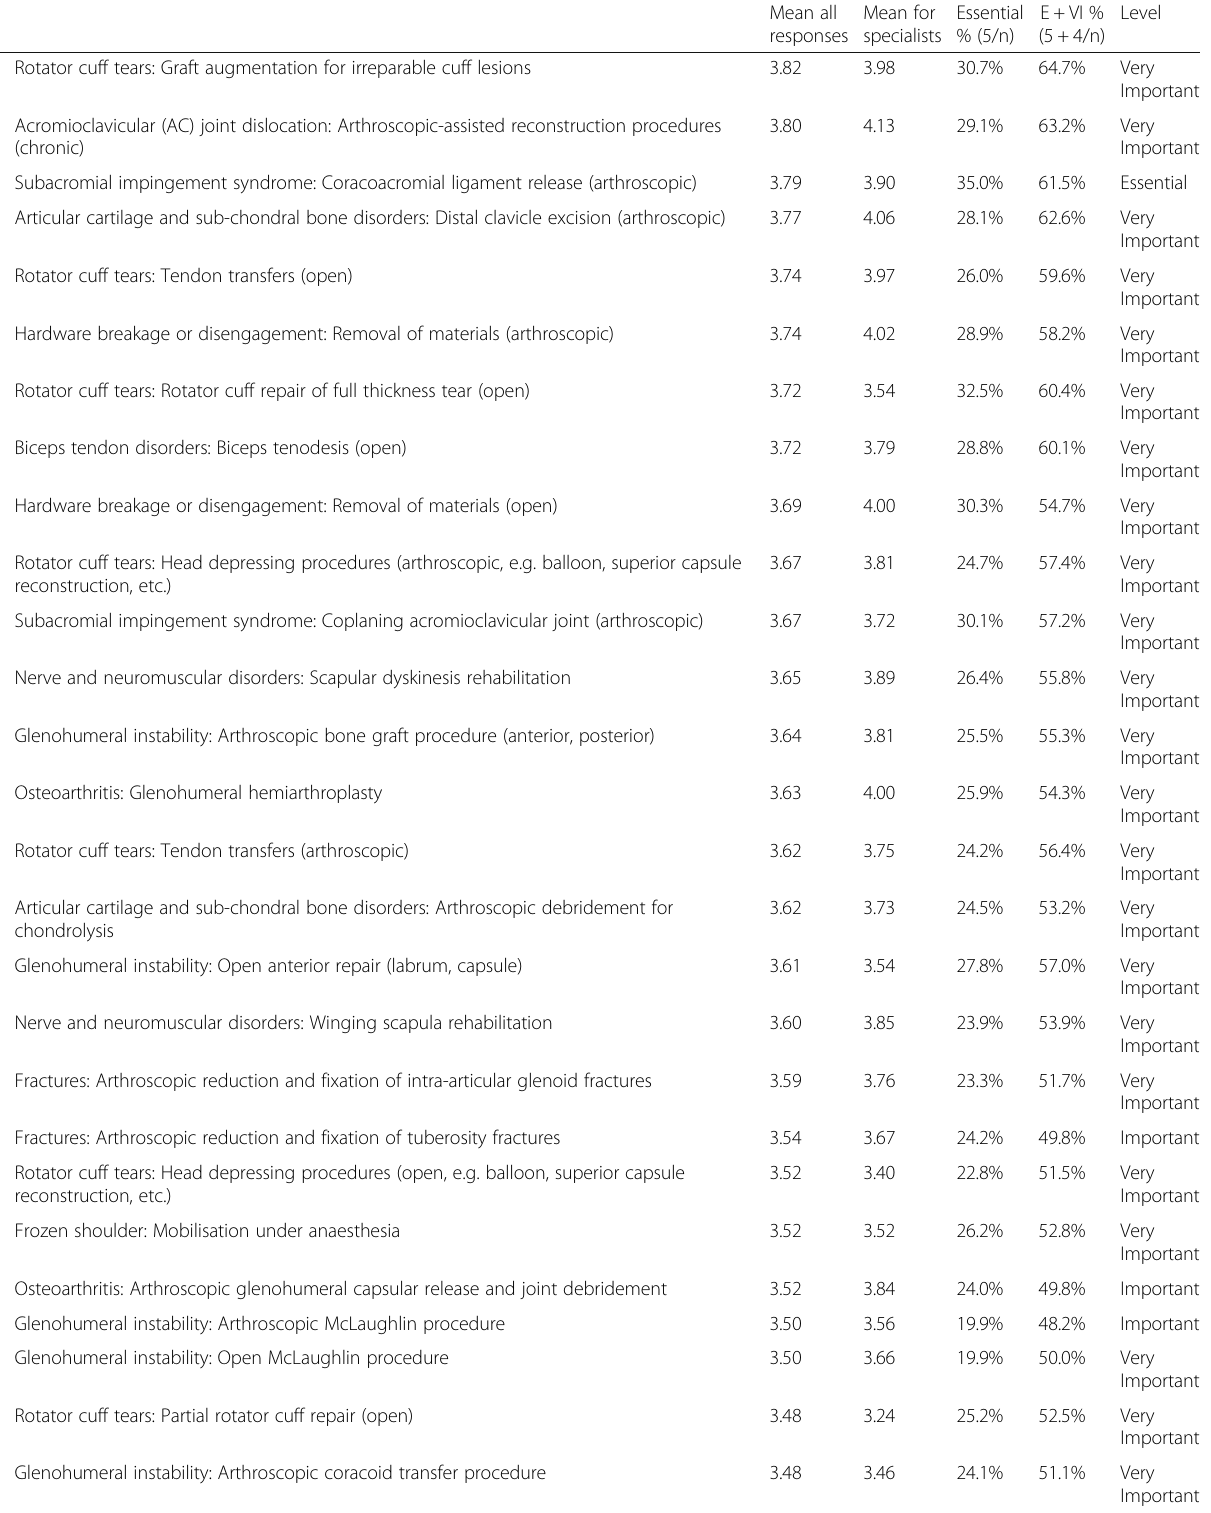
Table 2 For insertion in the results section as indicated above